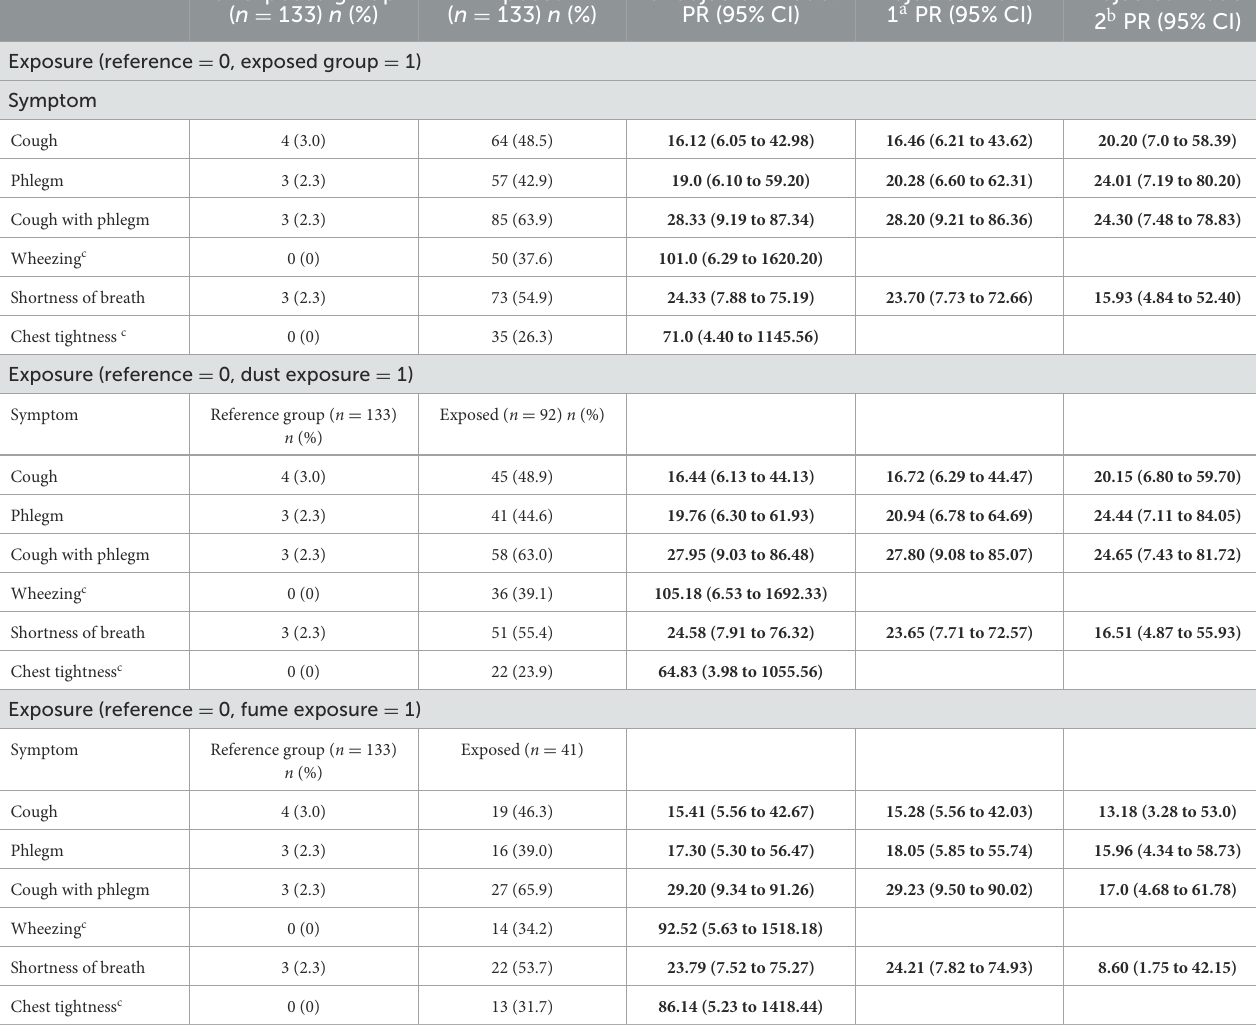
TABLE 3 Prevalence of respiratory symptoms among steel factory workers compared to the reference group. Unexposed group ( n = 133) n